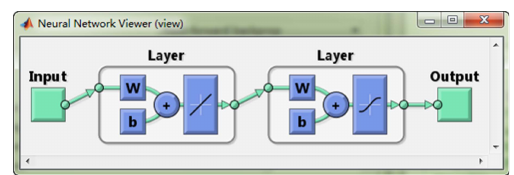
Figure 9. Schematic diagram of a three-layer neural